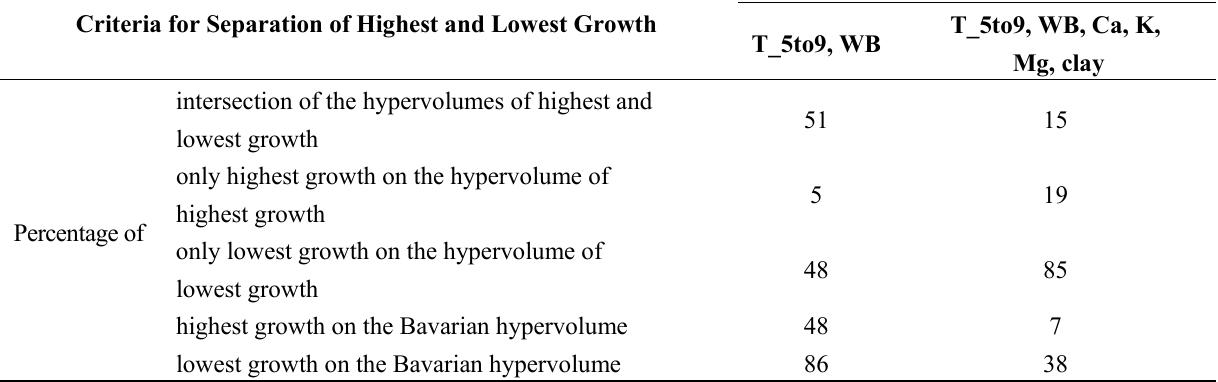
Table 4. Separation of plots with highest and lowest growth using hypervolumes constructed by different combinations of environmental variables.